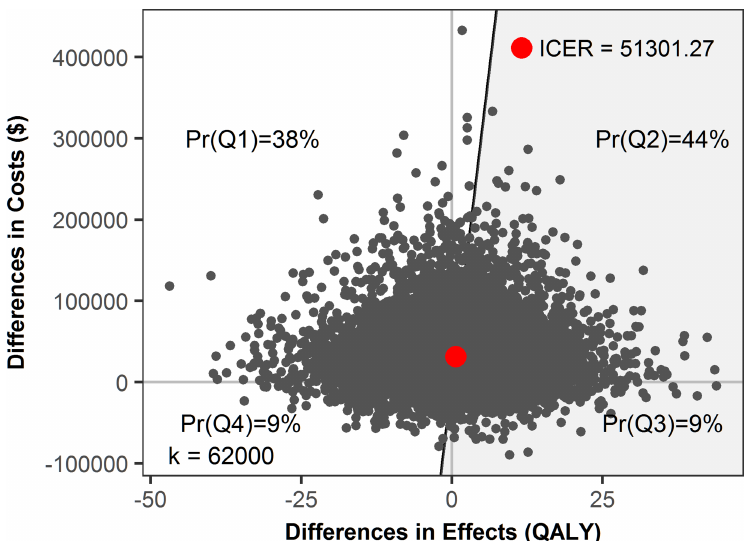
Fig 4. Simulated cost-effectiveness plane. The gray dots are individual simulations and the large red dot is the average. The shaded area below and to the right of the diagonal line is the cost-effective